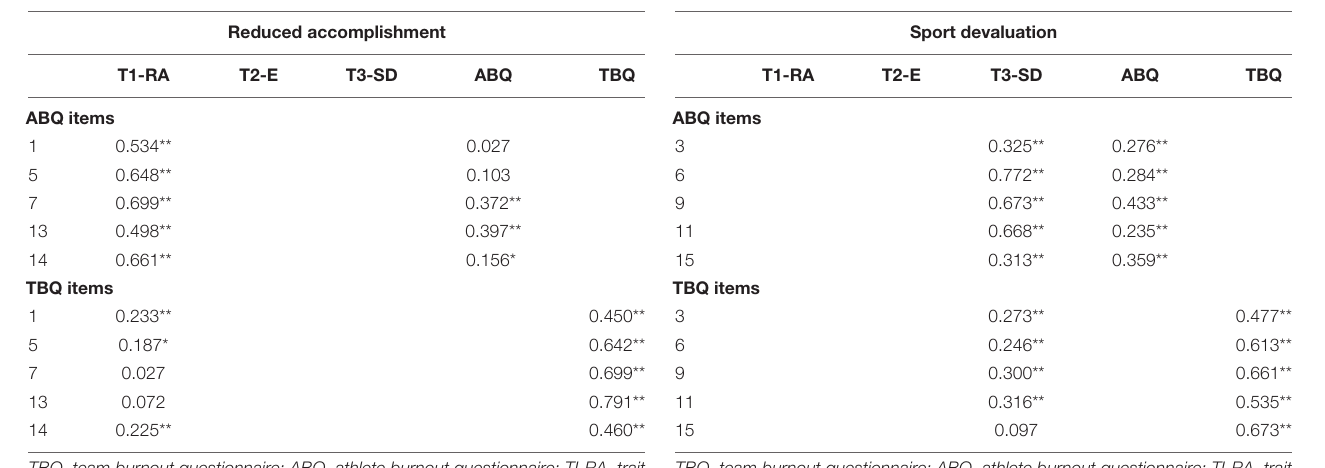
TABLE 5A | Standardized trait and method-specific factor loading in correlated trait/correlated methods (CTCM) Model (part